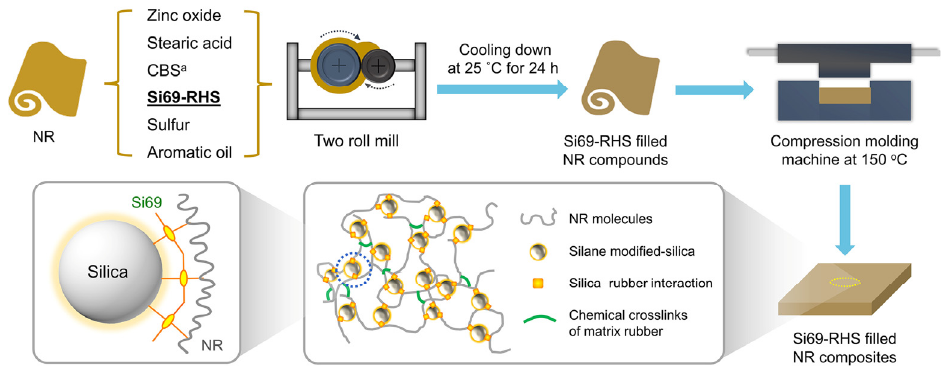
Figure 2. Schematic illustration showing the preparation of silica-filled NR composites. a N -Cyclohexyl-2-benzothiazolesulfenamide.